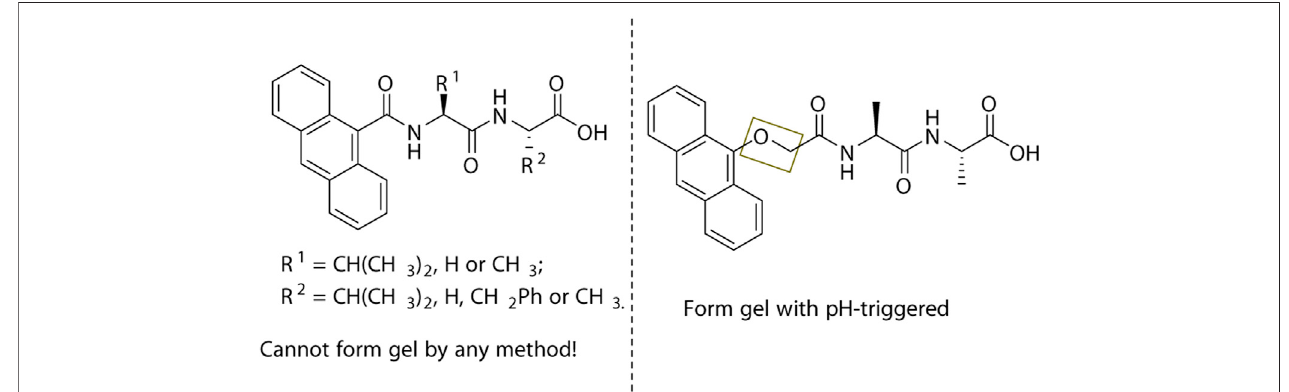
FIGURE 4 | The linker between the anthracene ring and dipeptide can affect gel formation.